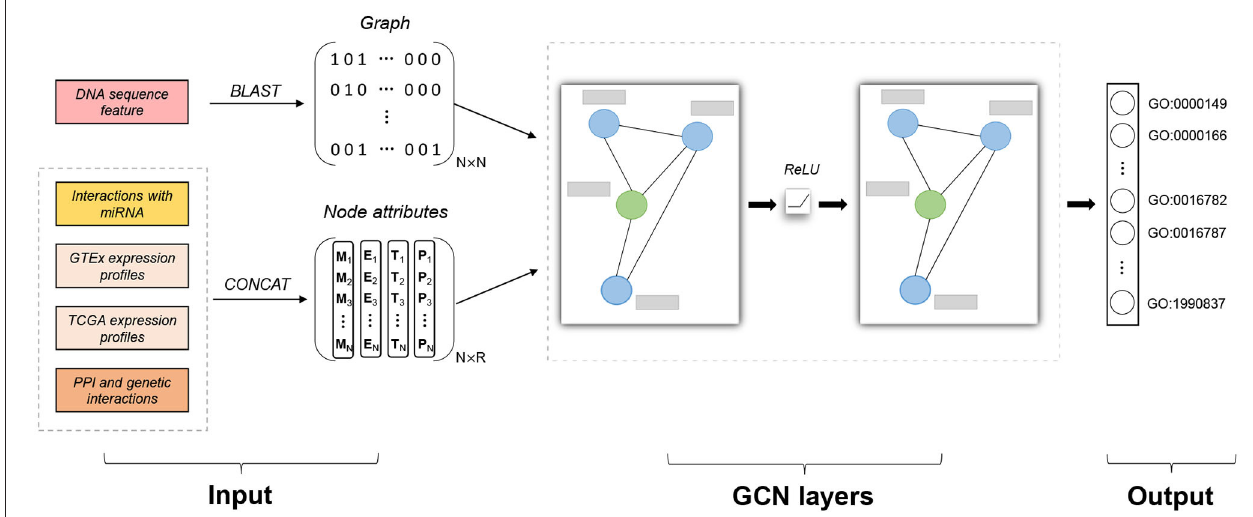
FIGURE 1 | Model architecture of Pseudo2GO. There are two types of input features: sequence similarity network (graph information) and node attributes (including four kinds of features). Similarity graph is obtained by running BLAST on DNA sequence features. Four kinds of node attributes are first encoded and then concatenated together to form the final node attribute matrix X with the dimension of N × R . Two layers of graph convolutional network (GCN) are stacked to process the attributed graph. The green node in the graph refers to a pseudogene, while the blue ones are coding genes. The gray bar represents node attribute vector for each gene (pseudogene or coding gene). The output is a set of GO terms we are going to predict (multi-label prediction). Our model gives a probability score for each GO term. Adam algorithm is used to train the model by minimizing the cross entropy error. Our model is a semi-supervised machine learning model, training on coding genes while testing on